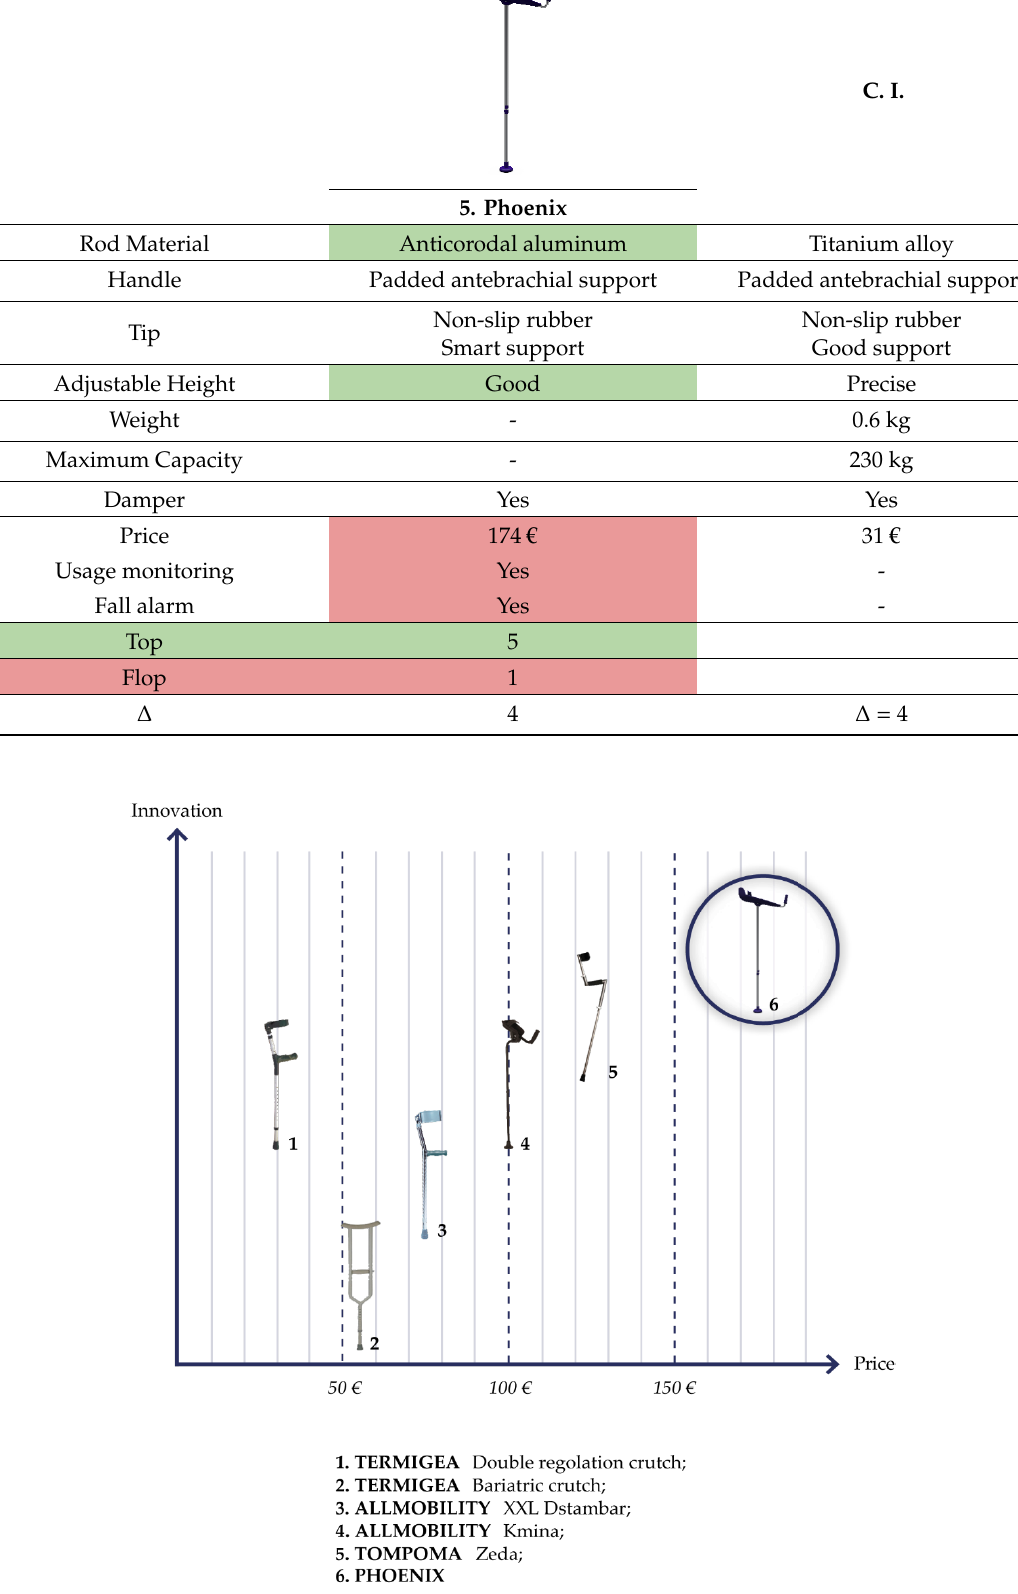
Figure 15. Innovation cross.